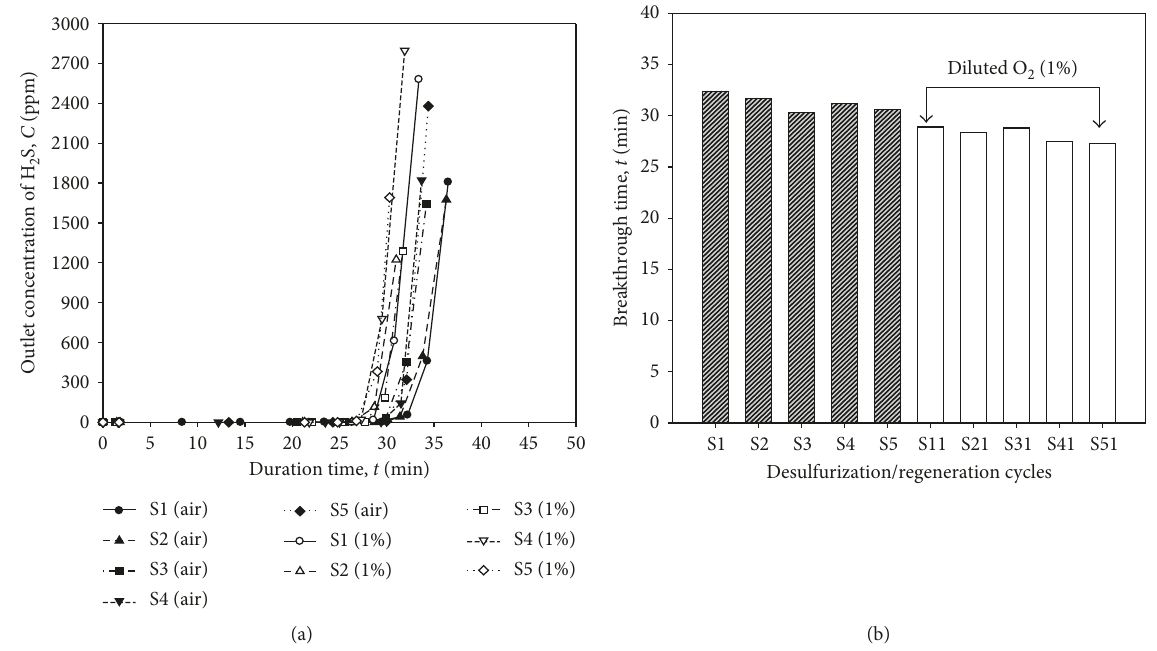
Figure 2: (a) Multiple regeneration cycles and (b) breakthrough time profile for different oxygen regeneration treatments.